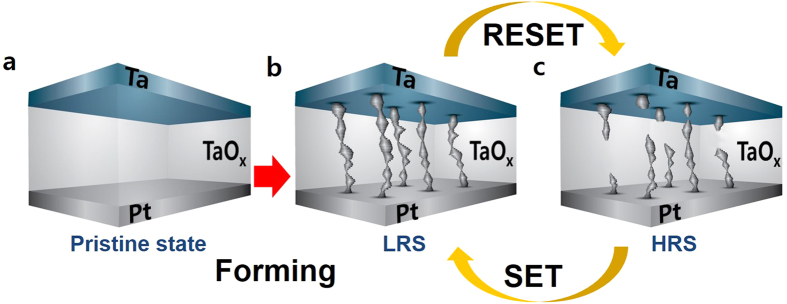
The schematic figures for a sequential RS cycle.(a), (b), and (c) show the pristine, the LRS, and the HRS of the Ta/TaOx/Pt device, respectively.